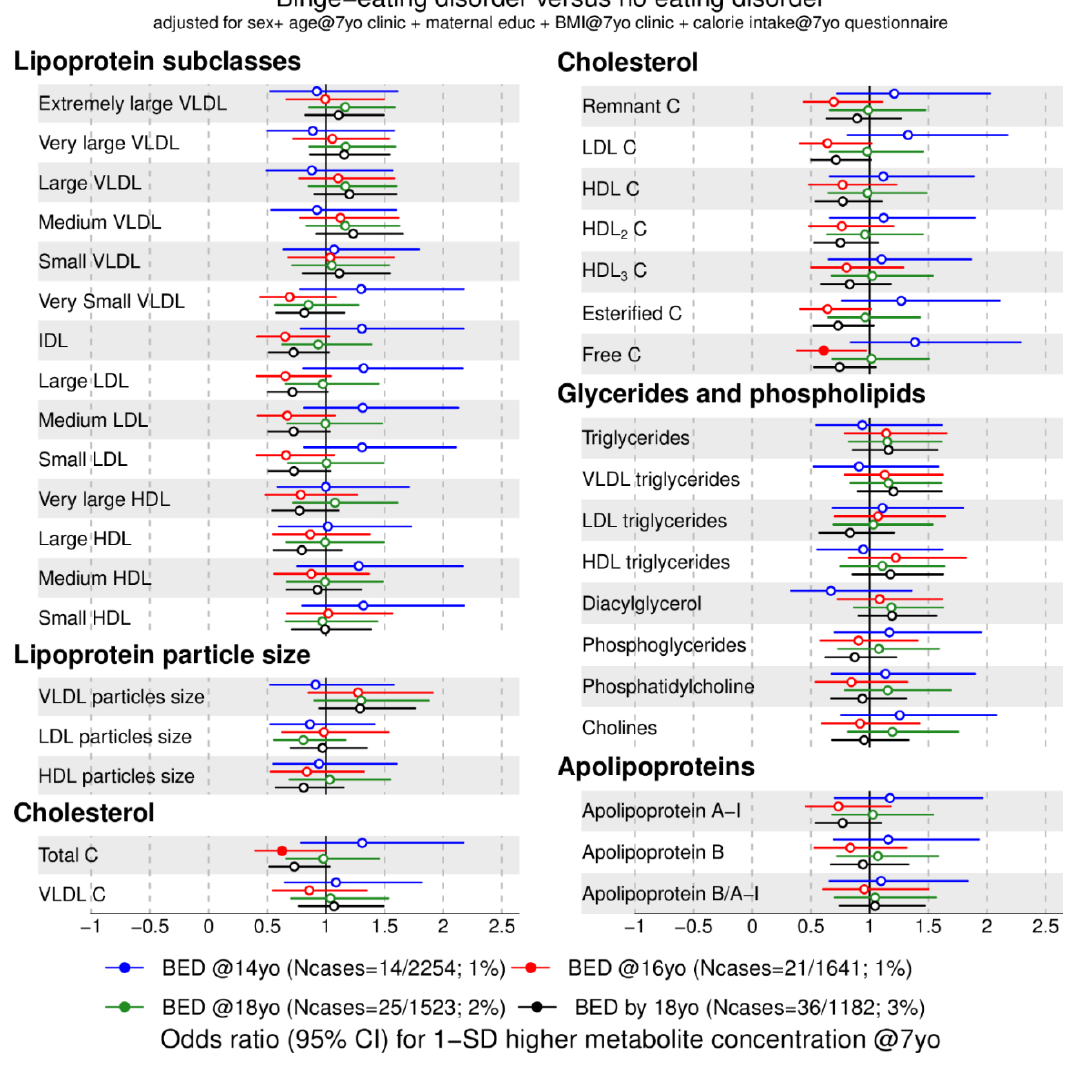
Figure 3. Estimated odds ratios for binge-eating disorder at 14, 16, 18 years of age and cumulatively across all three time points according to lipid-related metabolic trait concentrations at 7 years. Estimates refer to 1 standard deviation increase in metabolic trait concentration at 7 years (see also Table S3, Supplementary File). Error bars = 95% confidence intervals (CI). For lipoprotein subclasses, the total lipids ( = triglycerides + phospholipids + total cholesterol) point estimate (and CIs) of each 14 subclasses is presented. Estimated odds ratios and corresponding 95% CIs for particle concentration and specific lipids in each lipoprotein subclass are given in Figure S6a–c, Supplementary Material and Table S3, Supplementary File. Abbreviations: BED = binge-eating disorder; C = cholesterol; IDL = intermediate-density lipoprotein; LDL = low-density lipoprotein; HDL = high-density lipoprotein; VLDL = very low-density lipoprotein. Note: Filled dot: CI do not include the null.